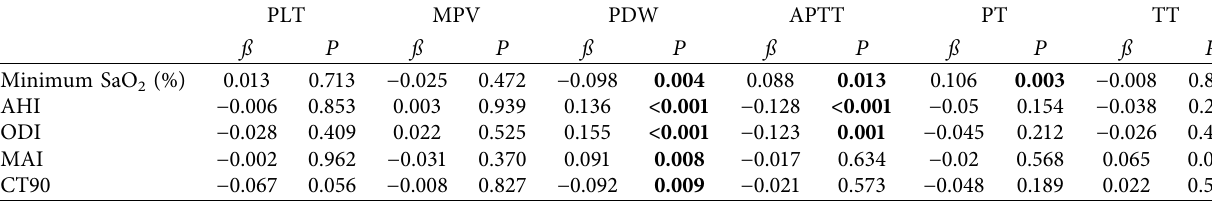
Table 2: Correlations between haematological data and breath-related parameters.